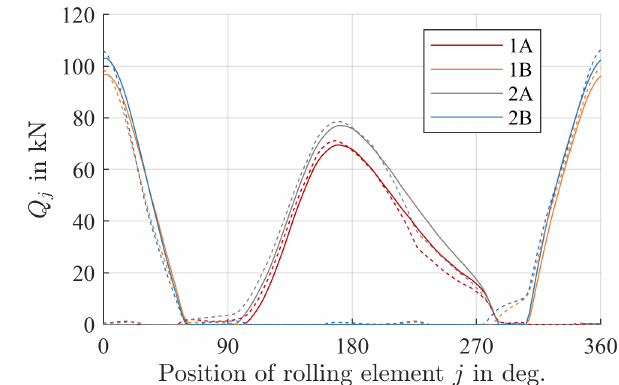
Figure 8. FE-simulated (solid lines) and interpolated (dashed lines) forces Q j for M = 20MNm, β = 90 ◦ , and θ = 10 ◦ .